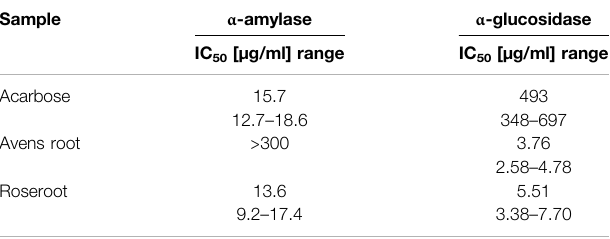
TABLE 2 | Combined effects of root extracts on in-vitro activity of α -glucosidase. Sample